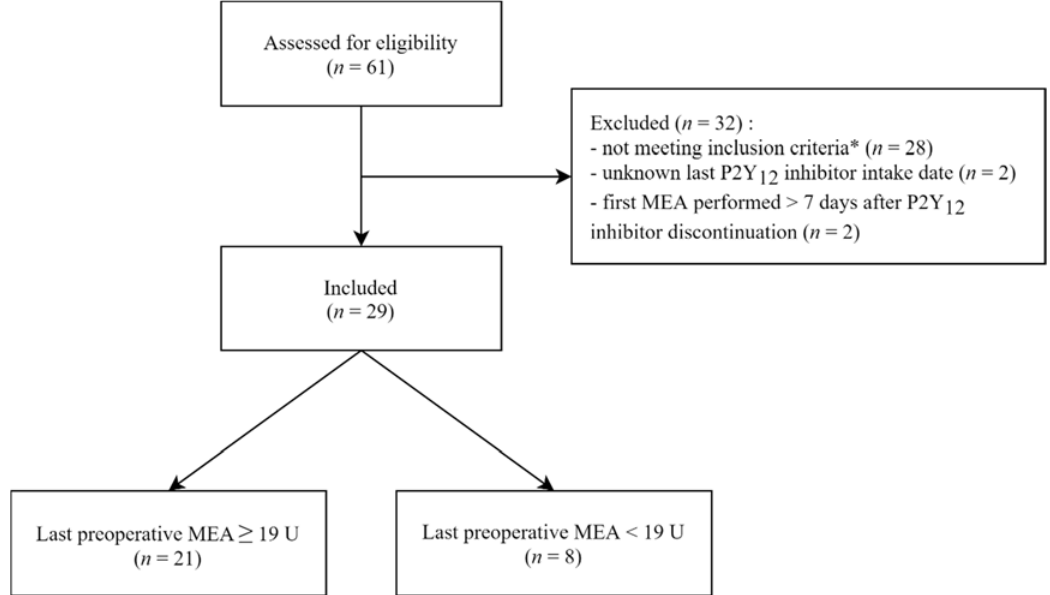
Figure 1. Patient flow diagram. Last preoperative multiple electrode aggregometry (MEA) test was performed 3.4 h (IQR: 0.7 ‒ 19.2) before surgery. * MEA not performed for a patient taking a P2Y 12 inhibitor or not realized before an invasive procedure.